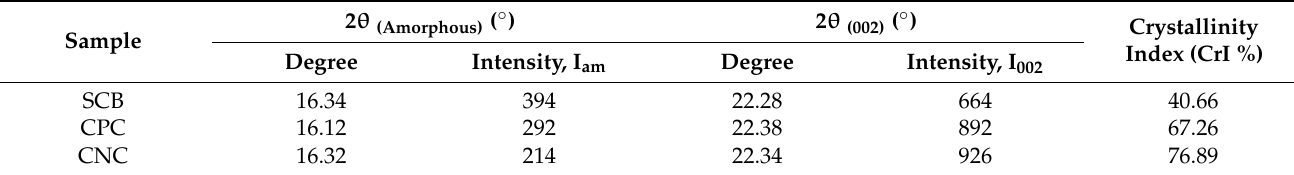
Table A1. Crystallinity of SCB, CPC, and